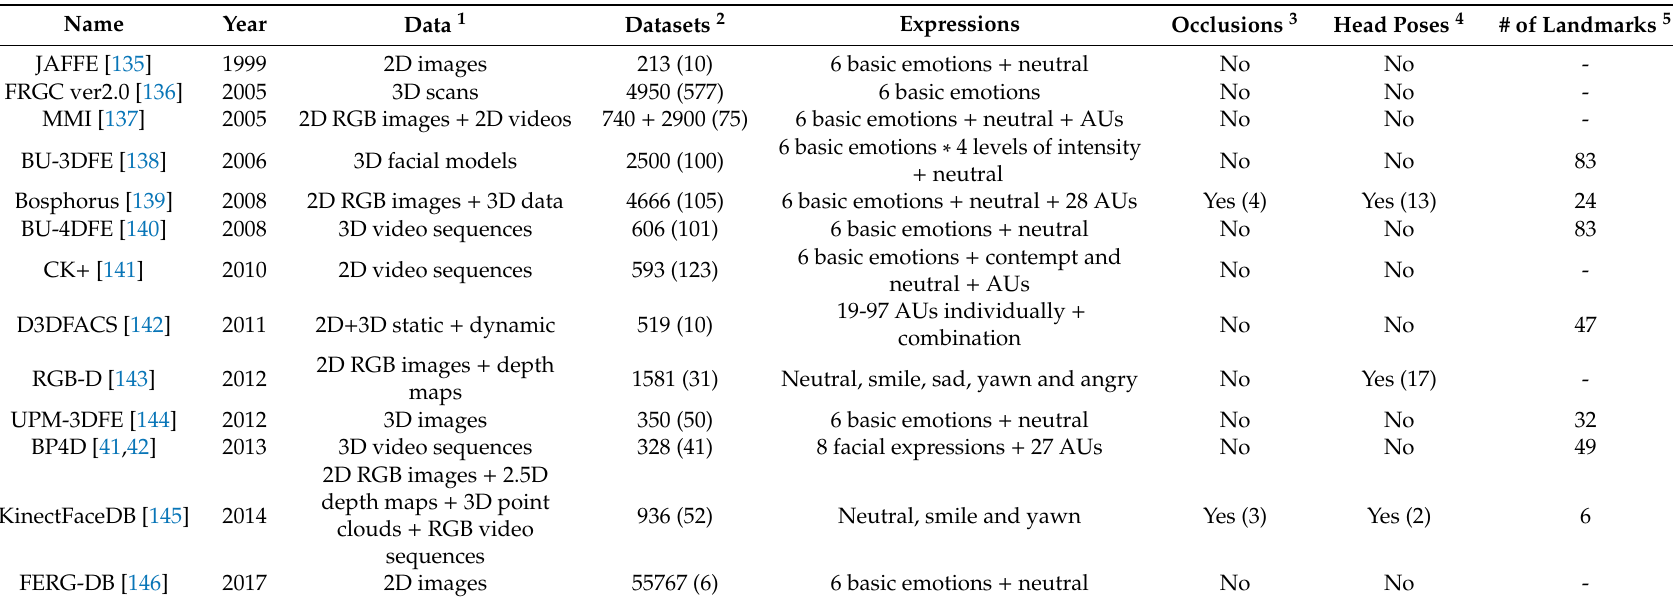
Table 4. A selection of face datasets employed in recent studies on expressions and AUs